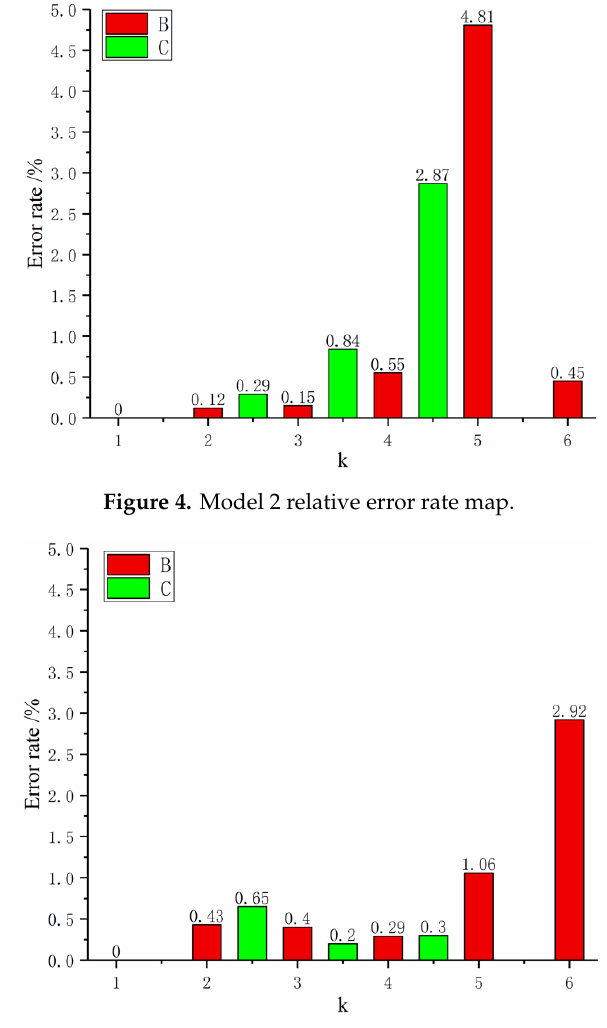
Figure 5. Relative error rate map of Model 3.